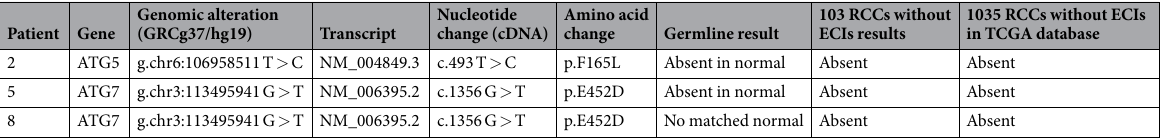
Table 3. Validated somatic mutations in ATG genes in ECI-containing DNA